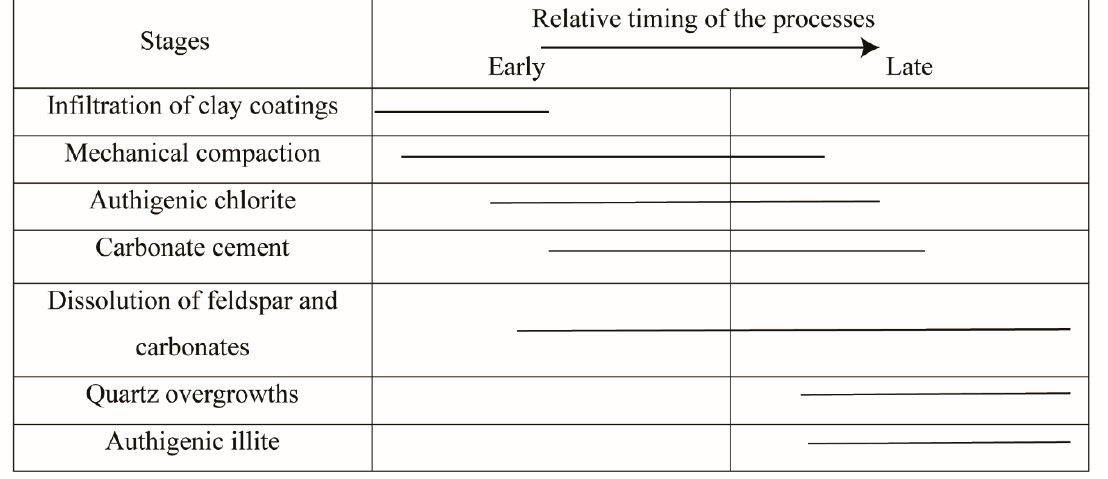
Figure 6. Relative succession of the diagenetic processes in the sandstones of the Surma Group from this study and previous studies across Bengal Basin [8–10].